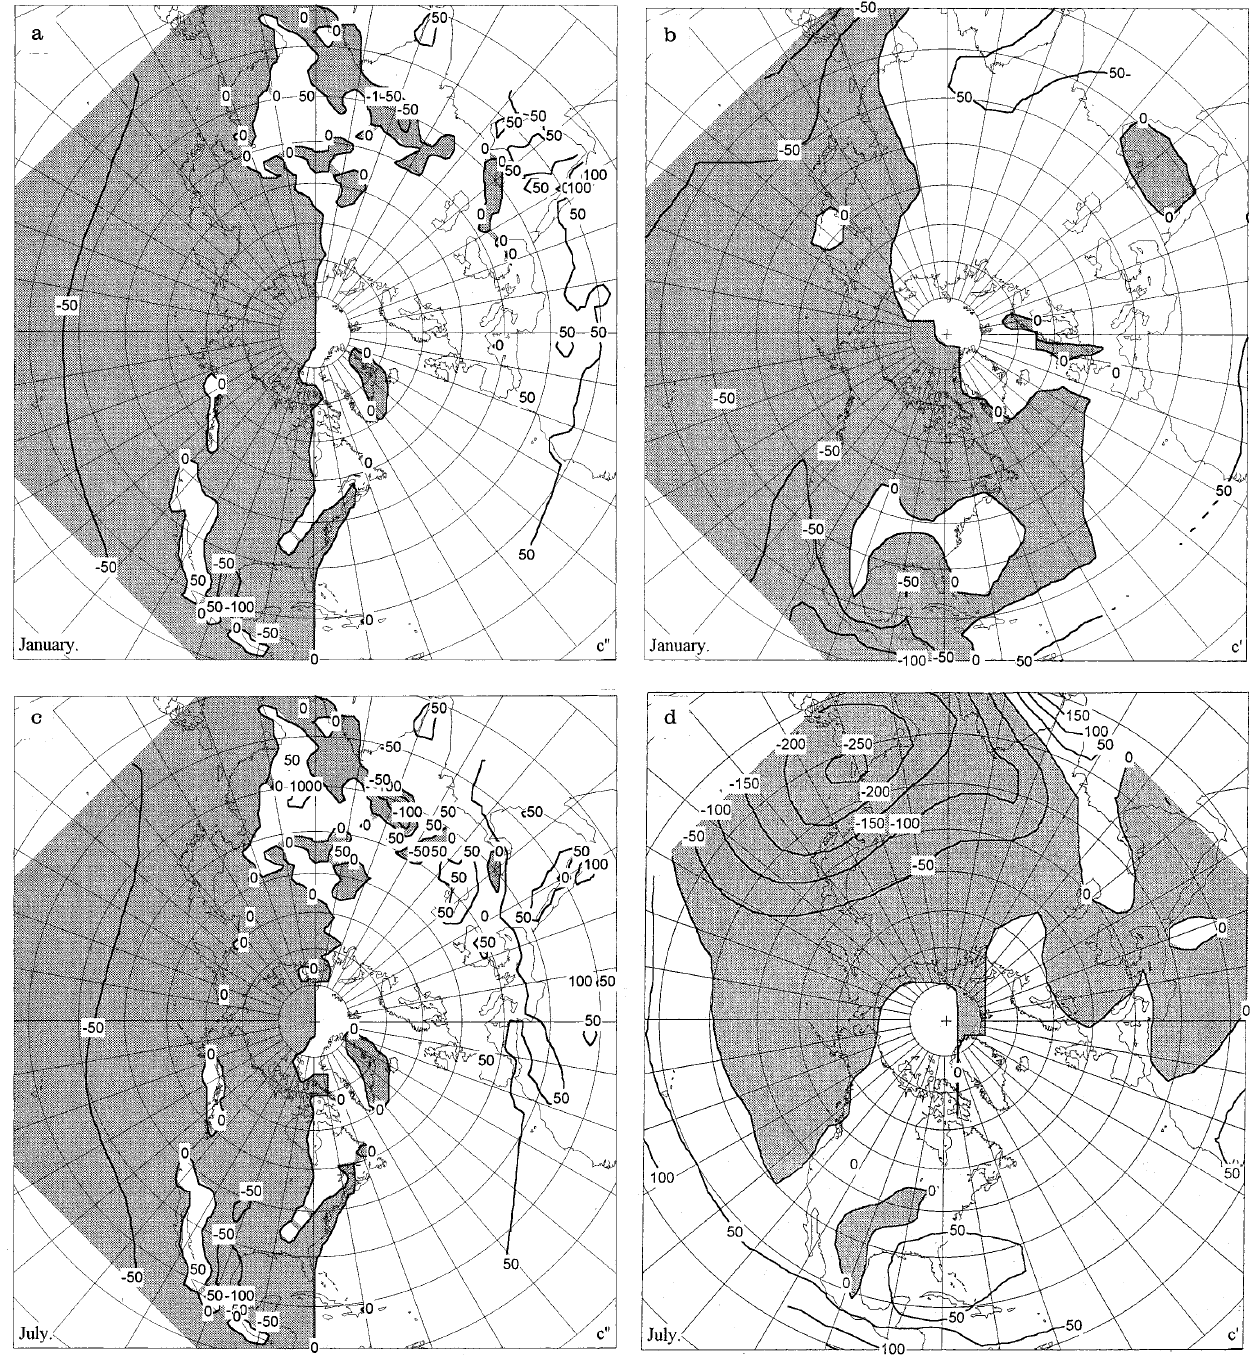
Fig. 3a–d. Geographical patterns of the c 00 coe(cid:129)cient in the theoretical Eq. (46), and the c 0 coe(cid:129)cient, in the Clapp et al. (1965) formula computed in 2 Wm (cid:255) 2 K (cid:255) 1 . a Is the c 00 coe(cid:129)cient for winter, b the c 0 coe(cid:129)cient for winter, c the c 00 coe(cid:129)cient for summer, and d the c 0 coe(cid:129)cient